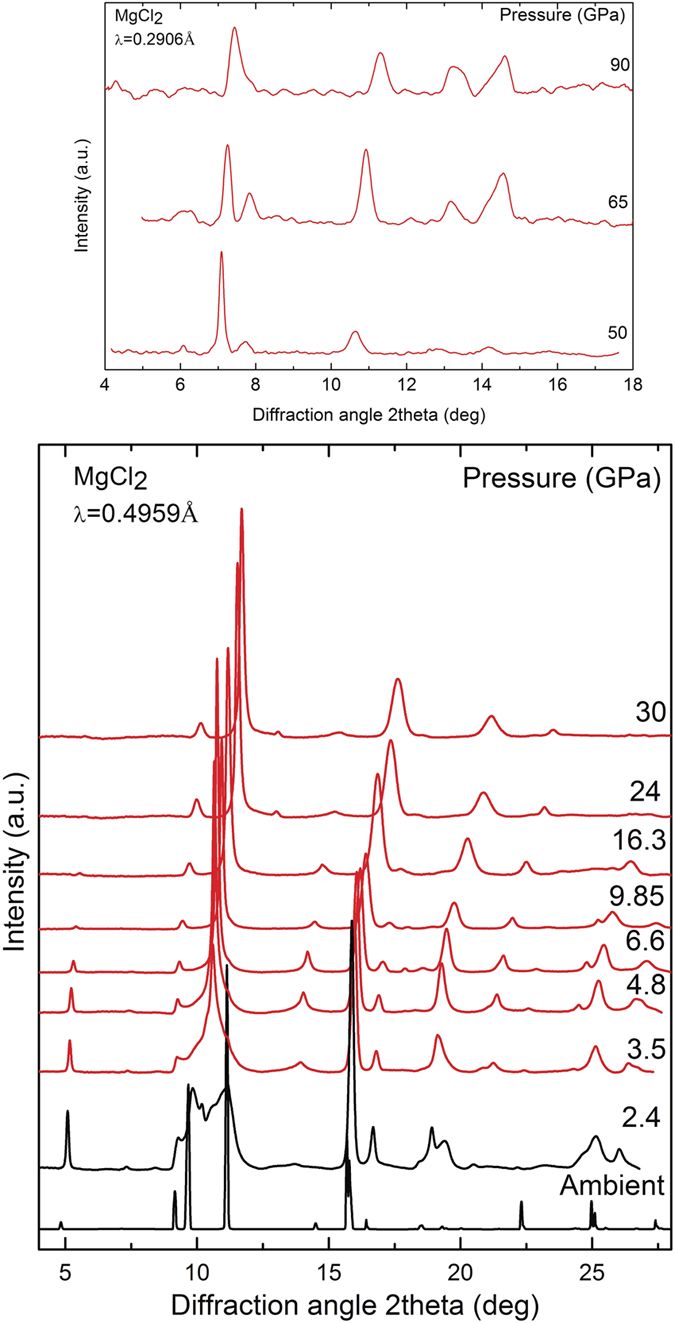
XRD patterns of MgCl2 at selected pressures.The patterns at 2.4 and 3.5 GPa correspond to a phase mixture of CdCl2- and CdI2-type phases.